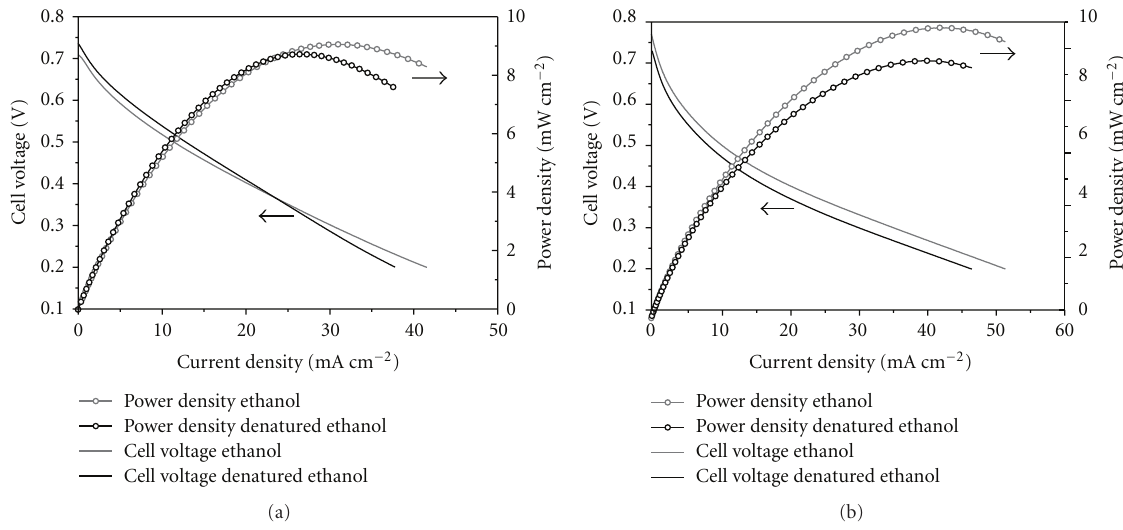
Figure 7: Fuel cell tests of pure ethanol (grey), ethanol solutions containing a mixture of ETBE and Bitrex (black) in acidic (a) and alkaline environment, (b). (a) PtSn + PtRu anode (3.68 mgmetal cm − 2 ), Nafion 115 membrane, and PtCo cathode (2.67mg metalcm − 2 ). 1mLmin − 1 aqueous 1M ethanol, 1.4 Lmin − 1 air, 50 ◦ C. (b) Acta Hypermec3 anode, Fumasep FAA membrane and Acta Hypermec cathode. 1mLmin − 1 10% ethanol + 10% KOH, 250mLmin − 1 air, 50 ◦